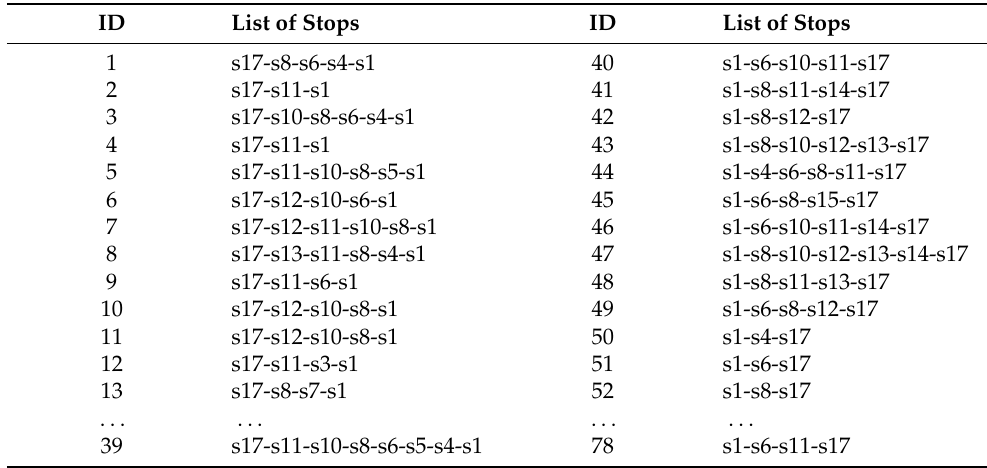
Figure 4. The distribution of passenger flow. Table 2. Set of possible lines.